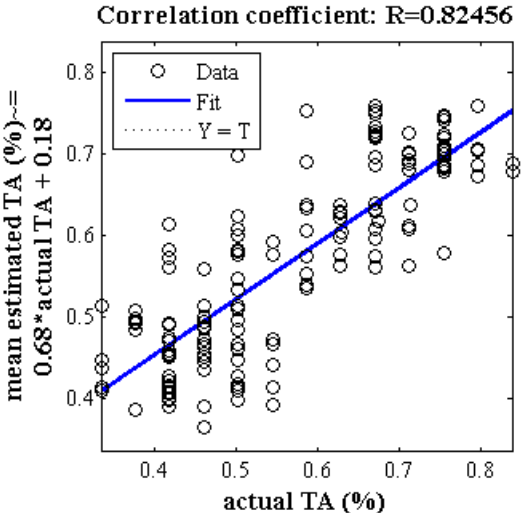
Figure 6. Correlation analysis of scatter plot between mean estimated and measured chemical properties of TA of Gala cultivar using PLSR method based on spectral data related to key wavelengths in 300 iterations.